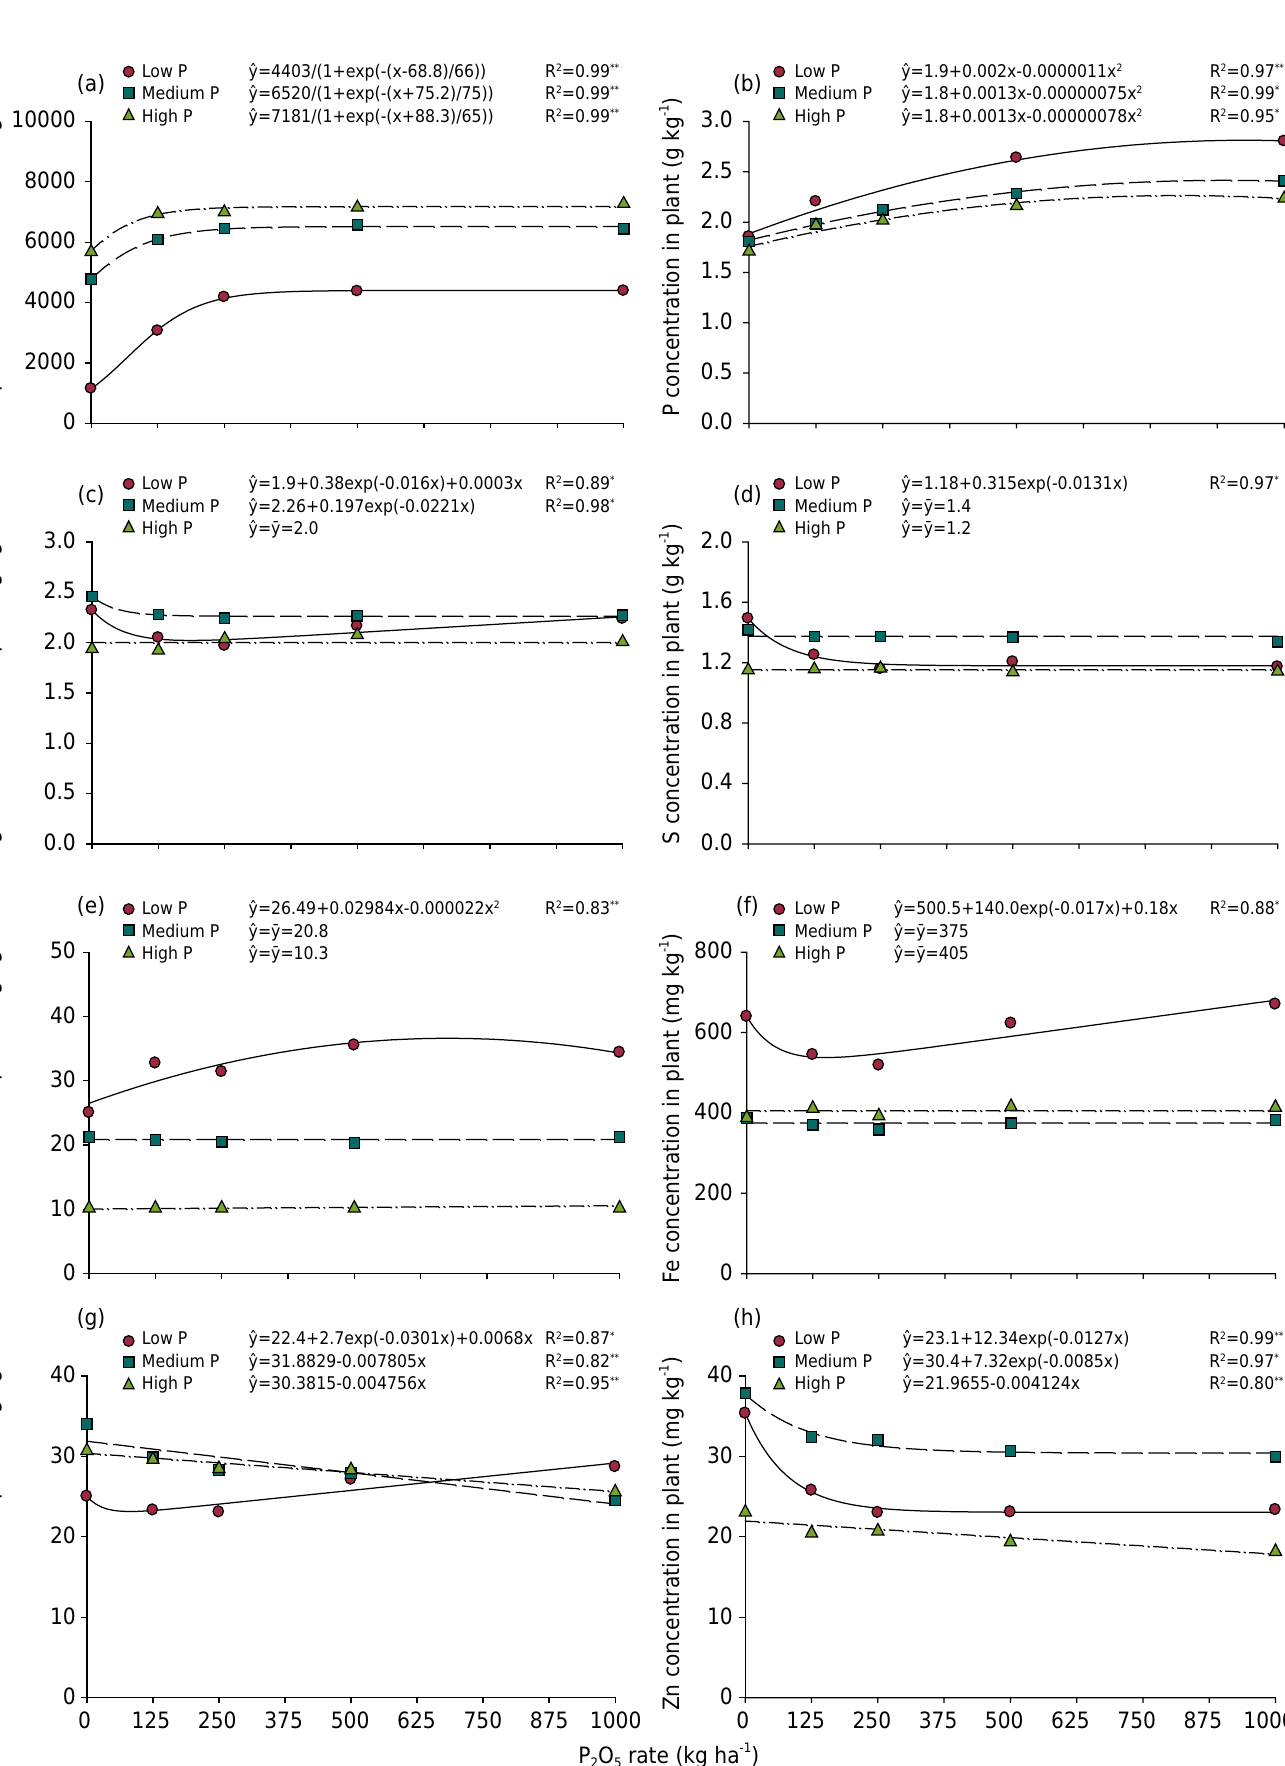
Figure 2. Whole plant dry matter (DM) accumulation (a), and concentrations of P (b), Mg (c), S (d), Cu (e), Fe (f), Mn (g), and Zn (h) in whole potato plants as affected by rates of P applied in the planting furrow in soils with low, medium, and high P availability. Mean of five cultivars. * and ** : significant at 5 and 1 % by the F